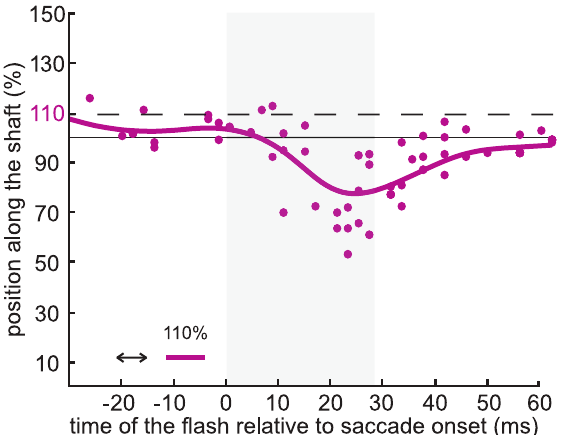
Figure 2. A mislocalization curve for one flash location and configuration of the Mu¨ller-Lyer figure. The dots represent the localization of individual flashes presented at various times relative to saccade onset. The curve is a smoothed average of these dots. This example shows data for one participant for flashes at 110% (dashed black line) of a 6.5 cm shaft length of the Mu¨ller-Lyer figure with a fins- in configuration. The solid black line at 100% represents the end of the shaft and the grey area shows the average saccade